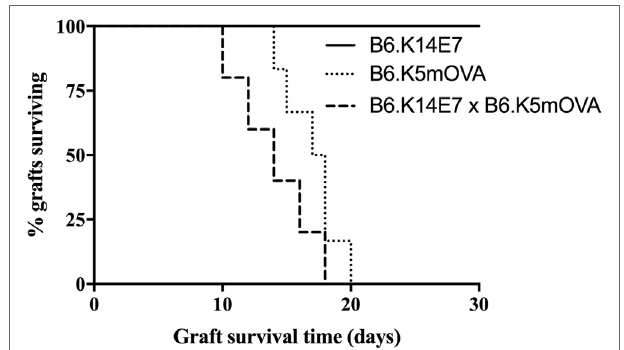
FigUre 1 | Fate of skin grafts expressing ovalbumin (OVa) with or without e7 protein . C57BL/6 (B6) mice received grafts of ear skin from B6. K14.E7, B6.K14.E7 × B6.K5mOVA, or B6.K5mOVA mice ( n = 5 or 6 per group as shown). Curves show graft survival. The difference between B6. K14.E7 × B6.K5mOVA and B6.K5mOVA graft survival was non-significant by log-rank test.